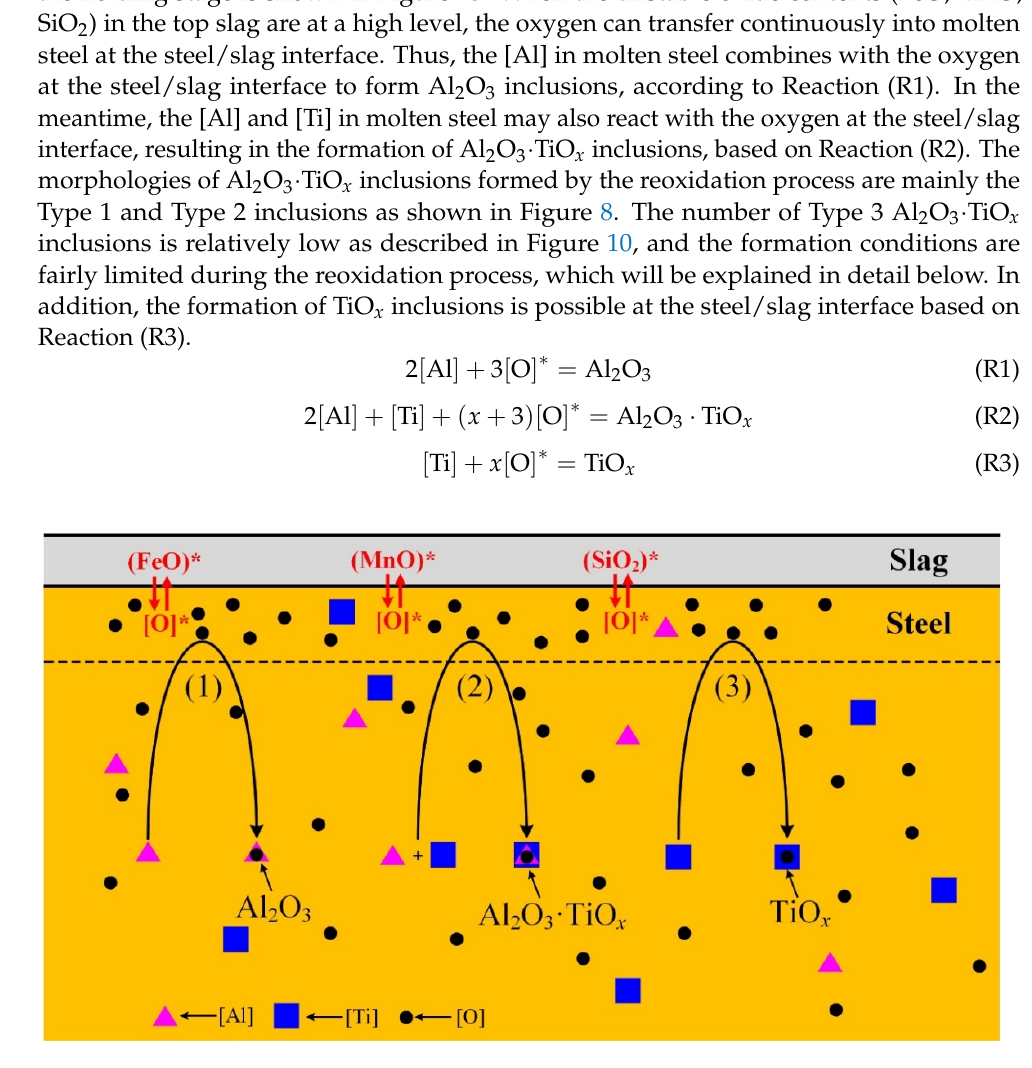
Figure 13. Mechanism of the reoxidation process of molten steel by the top slag during the holding stage. ing